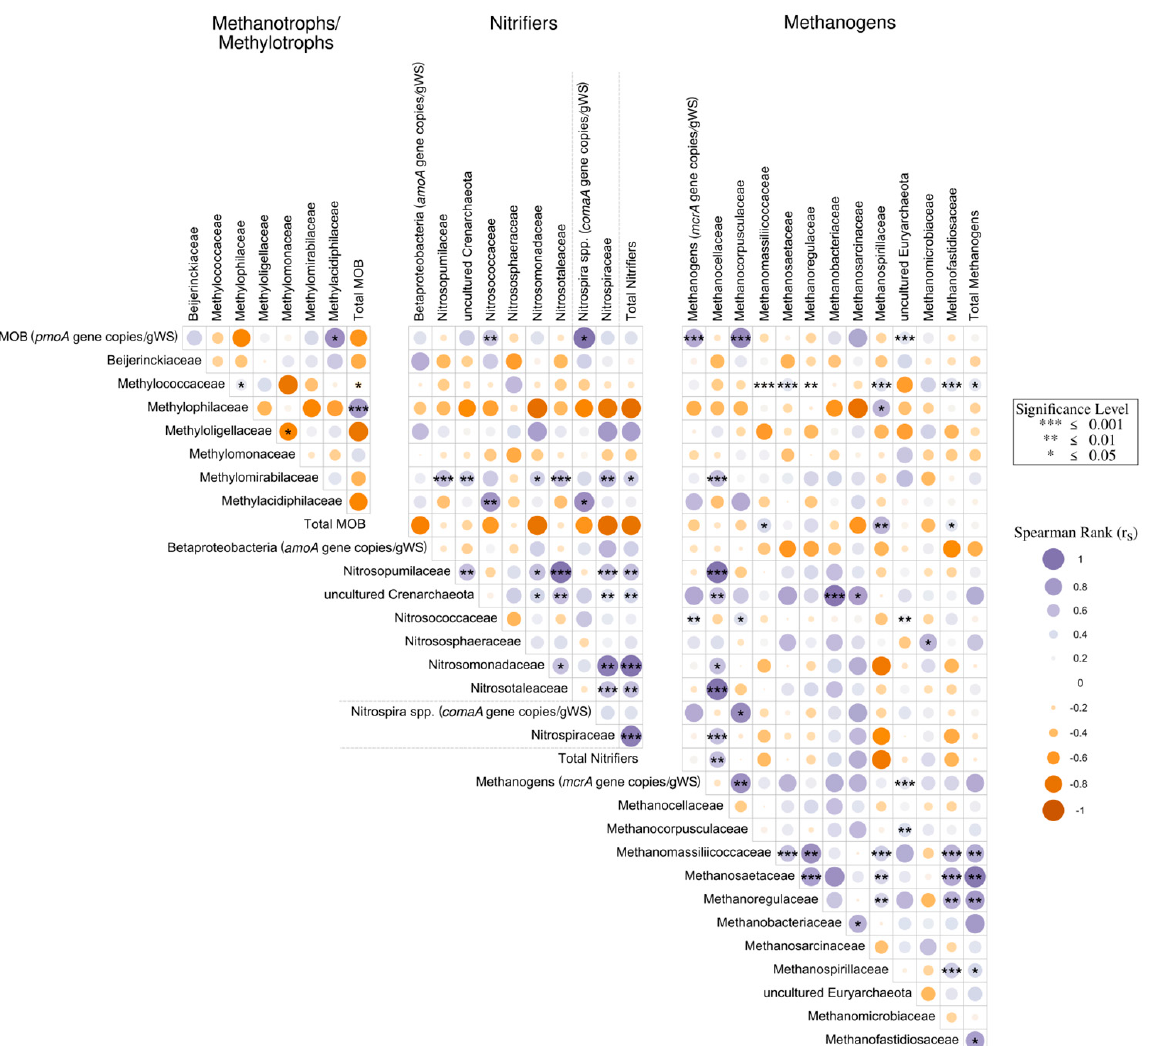
Figure 13. Spearman correlation analysis between functional microbial groups correlations based on qPCR genes abundances correlation with